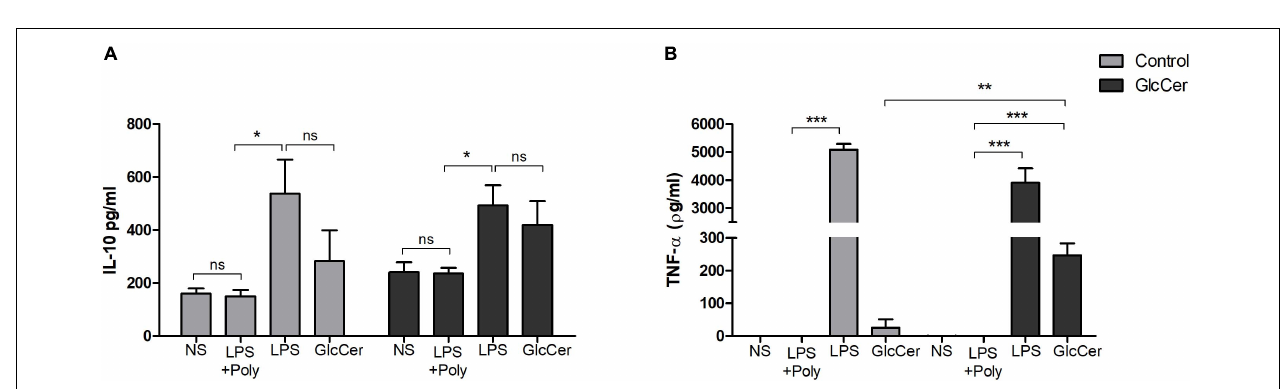
FIGURE 7 | Induction of cytokine secretion by peritoneal macrophages. Mice were stimulated with 200 µ g/100 µ l i.p. and 72 h later the macrophages were obtained from the peritoneal lavage and plated. In the control group the animals were stimulated with 0.5% DMSO in PBS. After incubation with the GlcCer species for 18 h, the culture supernatant was collected and the concentration of IL-10 (A) and TNF- α (B) were determined by ELISA. ∗ P < 0.05; ∗∗ p < 0.001; ∗∗∗ p < 0.0001; ns, no significant; NS, no stimulus; +Poly, polymyxin added.